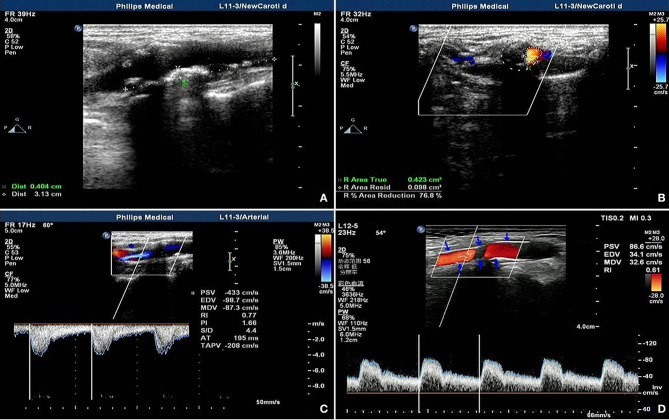
Ultrasonic manifestation before and after coronary artery stenting in patients predicted as having ideal outcomes. (A) shows multiple mixed echo mural plaques, some of which are unstable plaques; (B) shows cross section of stenosis, showing area stenosis rate of 76.8%; (C,D) show stenosis site before and after ESP respectively On the 30th day, the blood flow at the stent site showed that the shape and position of the carotid stent were good (the arrow showed the carotid stent), the blood flow in the stent was smooth, and the PV and RI were decreased.